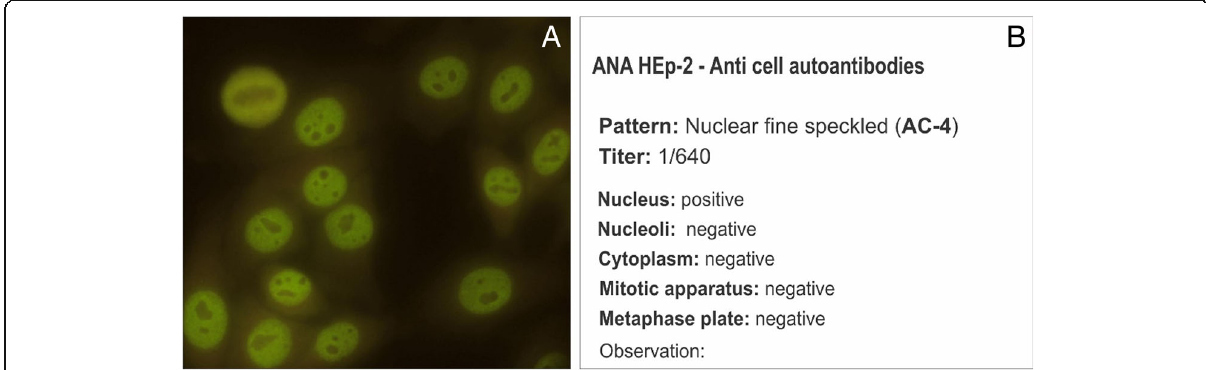
Fig. 3 Representative laboratory report of the Indirect immunofluorescence assay on HEp-2 cells, expressing the AC-4 pattern. ( a ) Representative image. ( b ) Model report as recommended by the V